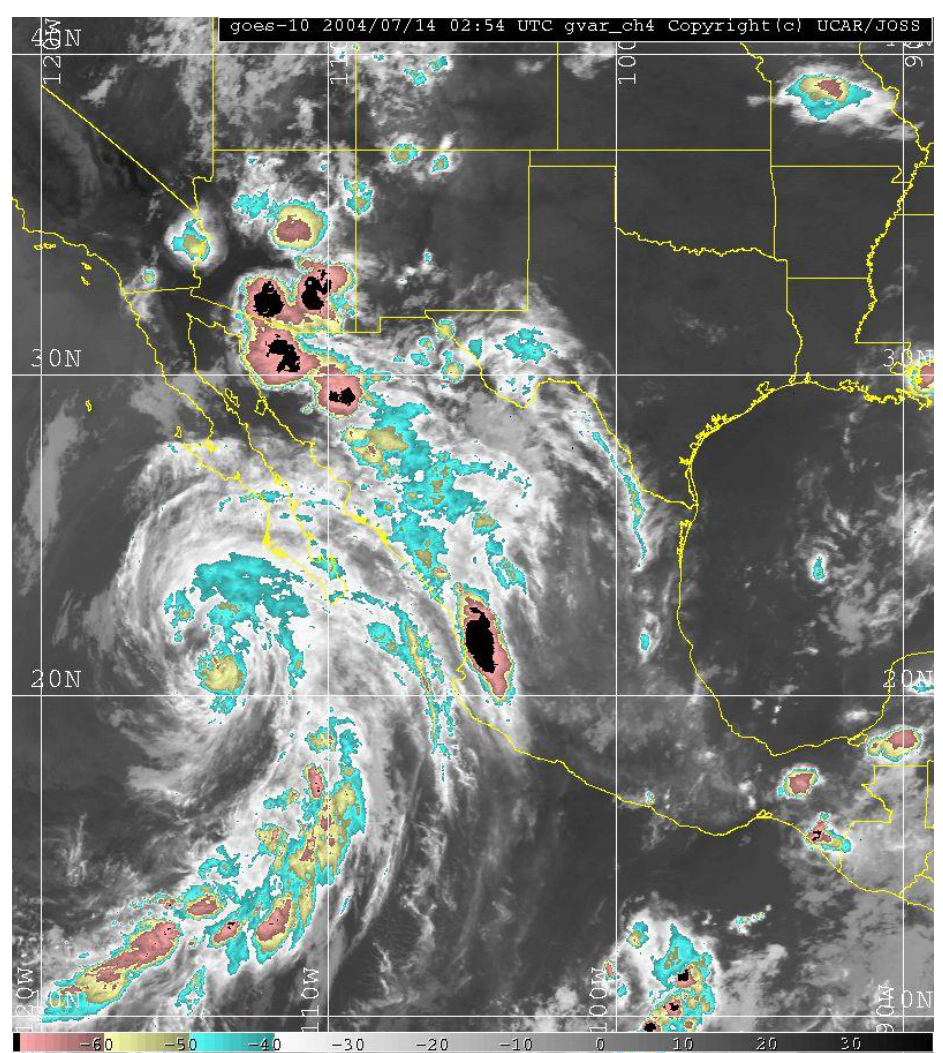
Figure 4. GOES 10 satellite enhanced infrared imagery (4 km_ch4_thermal-IR) during period of MCS development within NAME IOP 2. Specific time of image is 0254 UTC 14 July 2004. From NCAR/EOL.